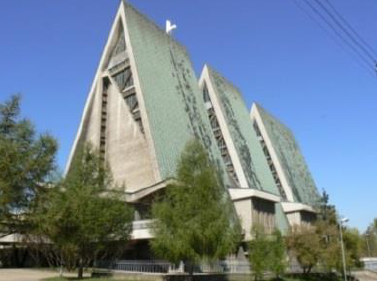
Figure 9. Church of St. Adalbert in Częstochowa (built in 1978–85).